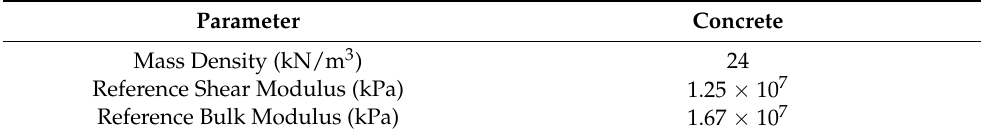
Table 1. Foundation parameters.